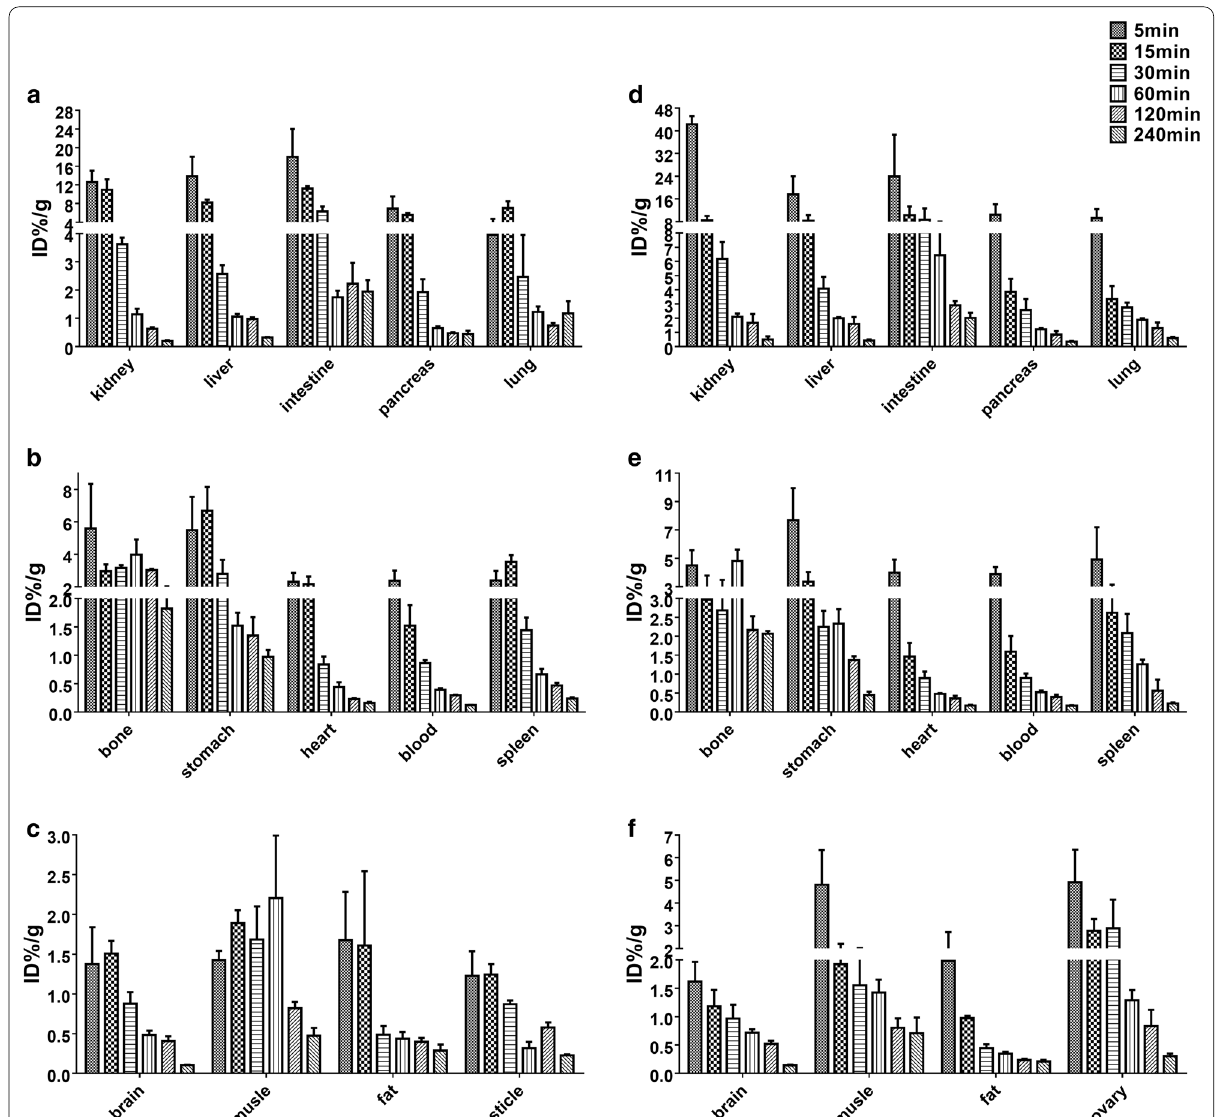
Fig. 7 Biodistribution of 18 F-deoxy-thiamine in ICR mice. a – c Male. d – f Female. Radioactivity accumulation was expressed as %IA/g at 5, 15, 30, 60, 120, 240 min after tail-vein injection of 3.7 MBq 18 F-deoxy-thiamine in 0.1 ml volume. n kidney, lung at 5 min of male, and kidney, liver, duodenum, lung, ovary at 5 min of female ( n